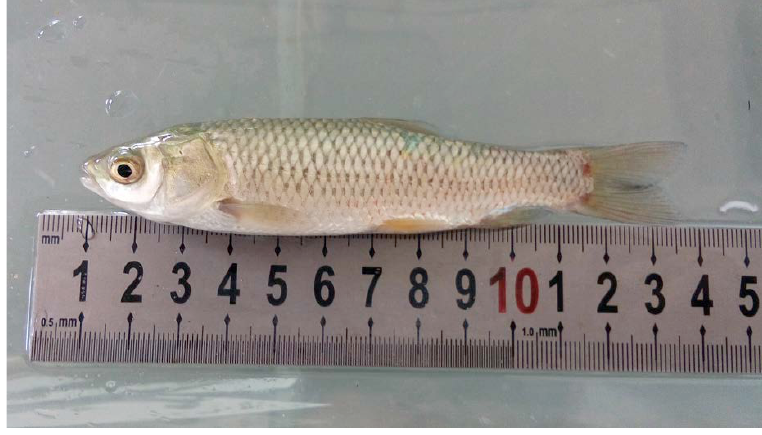
Figure 2. Sample of tested juvenile grass carp.